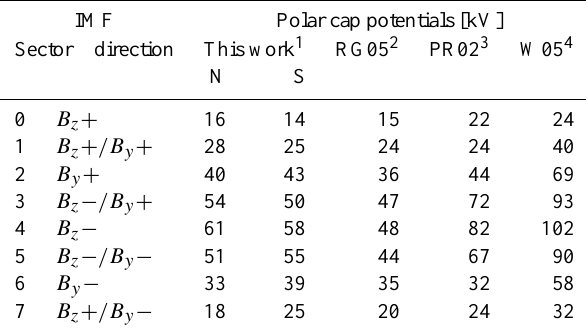
Table 3. Polar cap potentials compared with SuperDARN radar observations (Ruohoniemi and Greenwald, 2005) and a semiempir- ical model based on measurements from the Dynamics Explorer 2 spacecraft (Weimer, 2005).